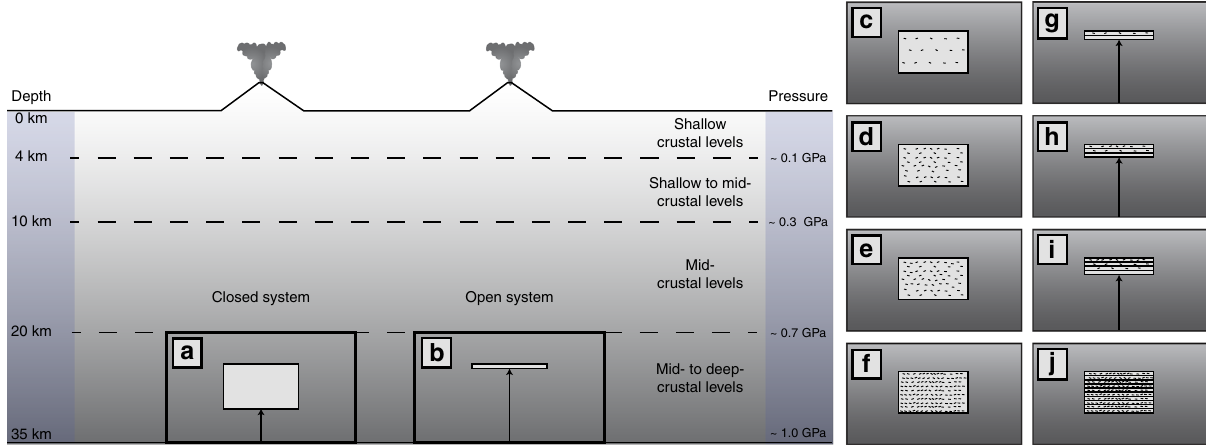
Fig. 8 Conceptual model for the thermal numerical simulations. a the closed-system scenario; b the open-system scenario. The evolution of the closed system is schematically described in c – f . The evolution of the open system is described in g –